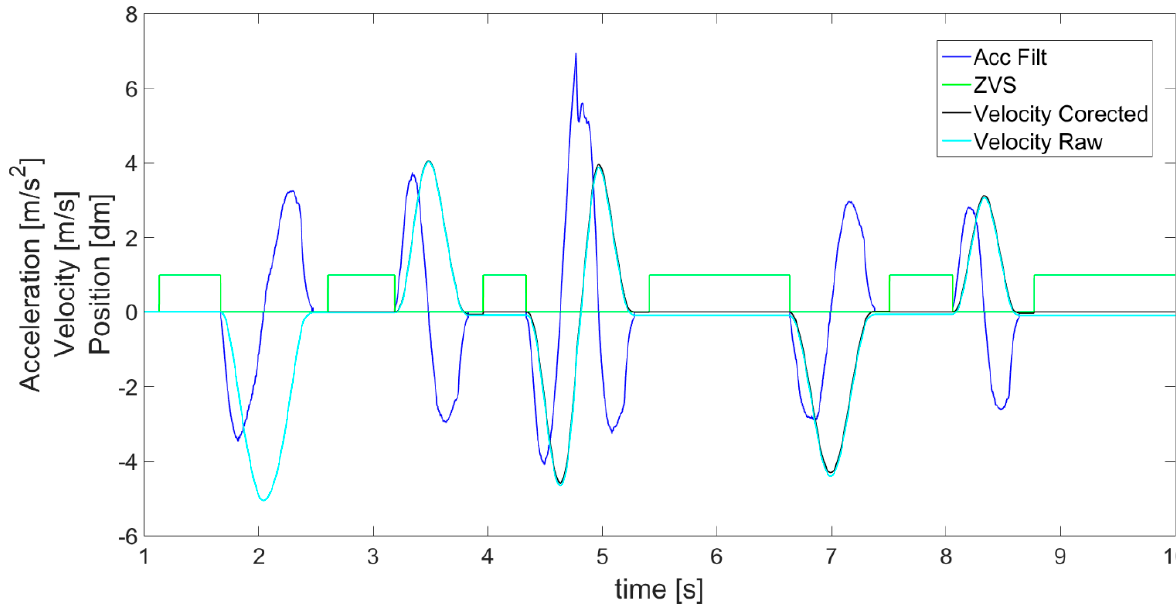
Figure 7. Detection of zero velocity states (ZVS indicated as green line) and 1st velocity correction.